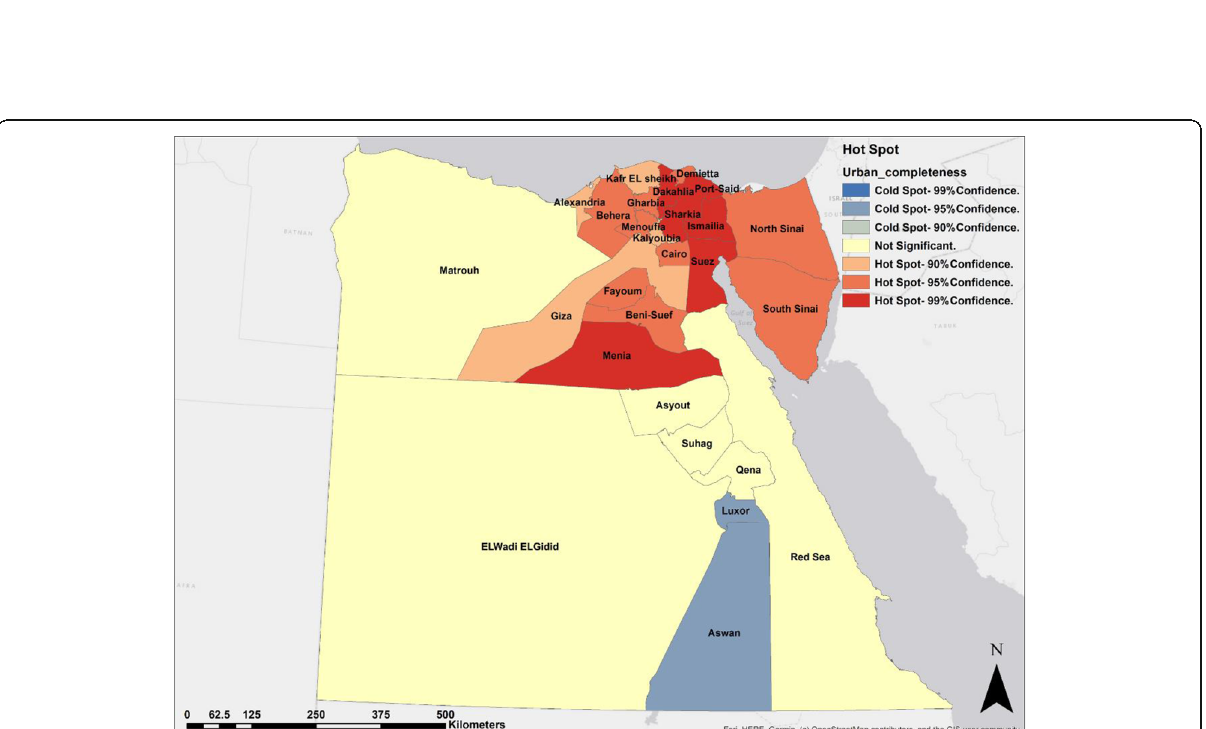
Fig. 5 Hot spots of the completeness of urban death registration, Egypt,